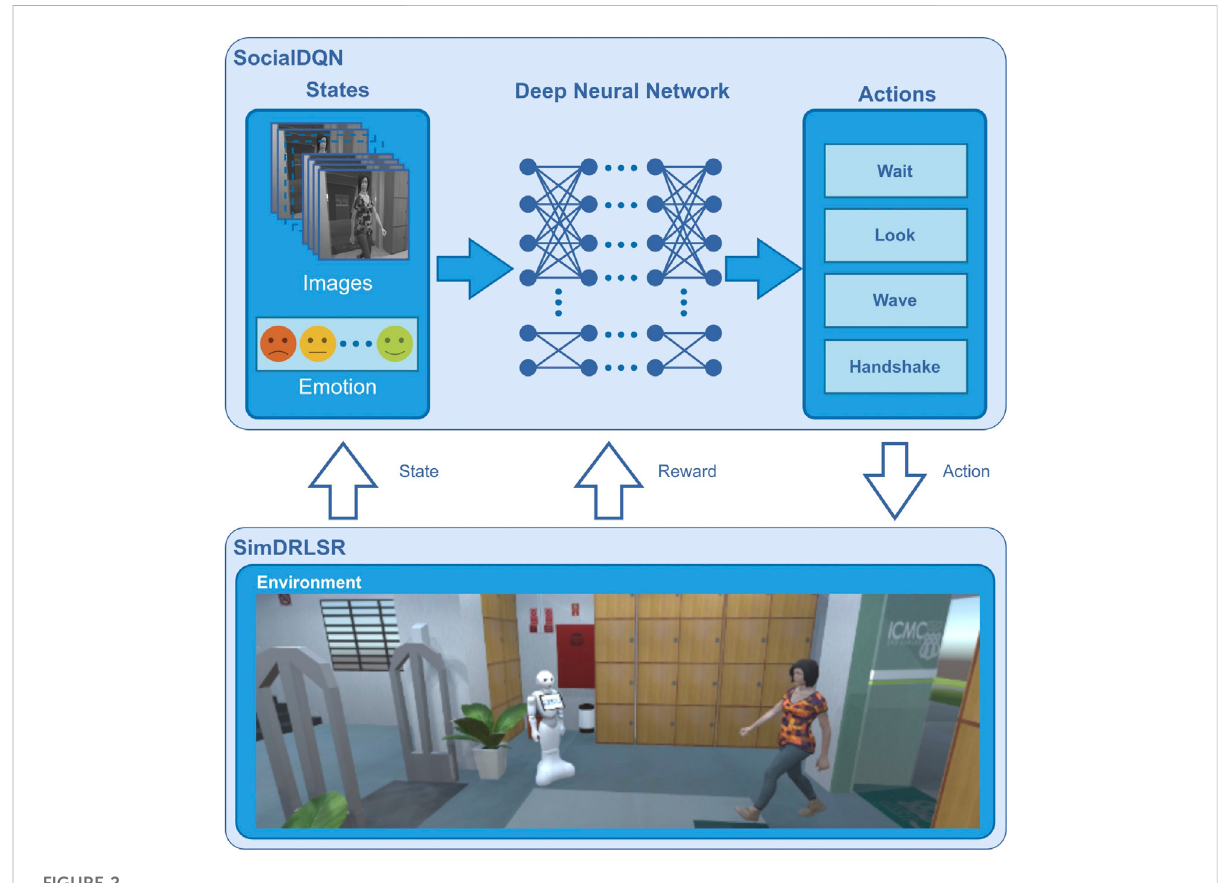
FIGURE 2 SimDRLSR and